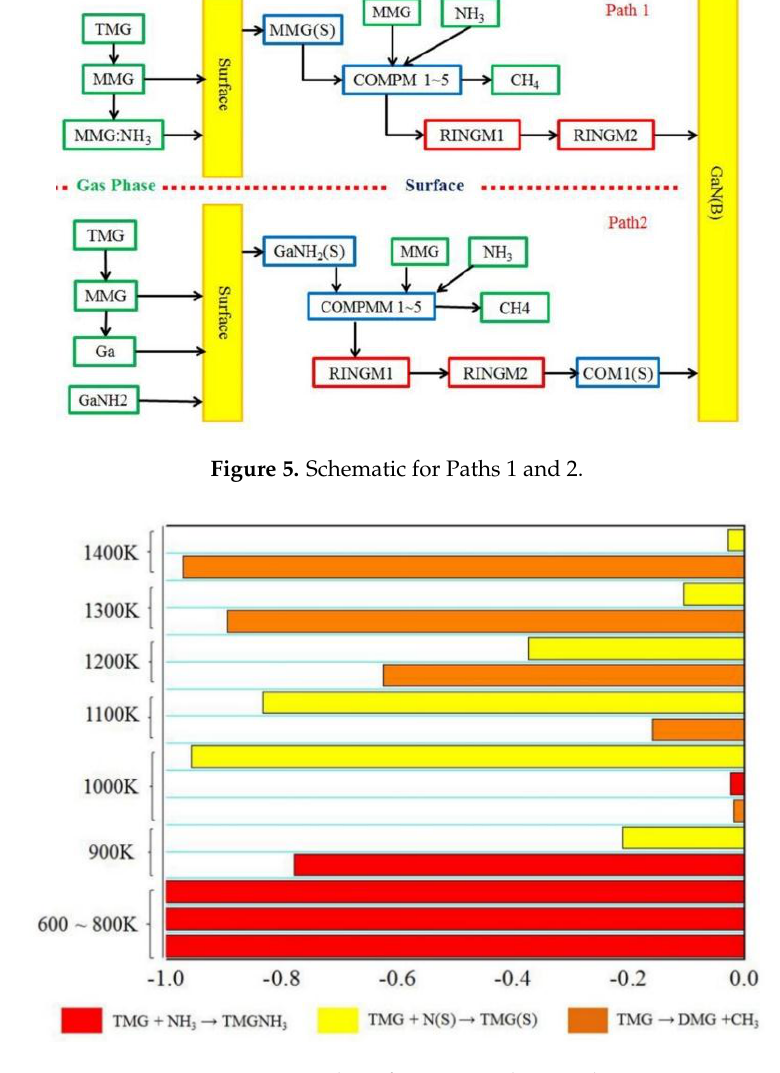
Figure 7. ROP analysis for DMGa in the gas phase. Figure 8. ROP analysis for MMGa in the gas phase.